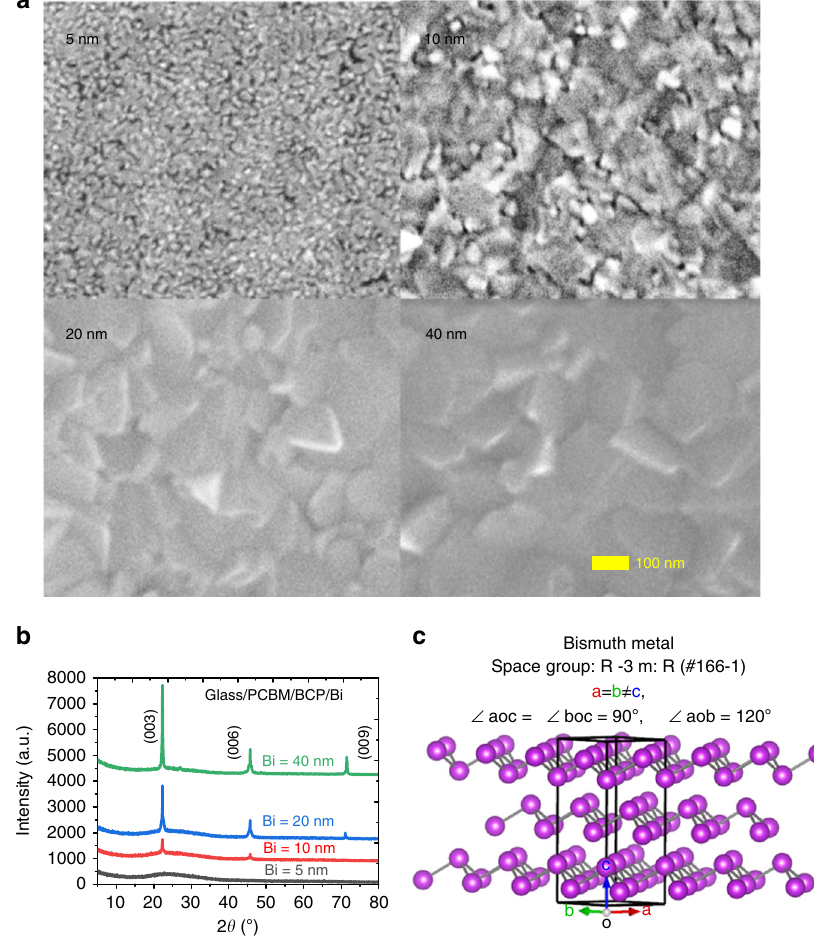
Fig. 2 Structural properties of the bismuth fi lm. a SEM images of the as-deposited Bi fi lms on Glass/PCBM/BCP substrates with different thicknesses (scale bar: 100 nm); b XRD patterns of the as-deposited Bi fi lms on Glass/PCBM/BCP substrates with different thicknesses; and c schematic diagram of the crystal structure of Bi. Source data are provided as a Source Data fi